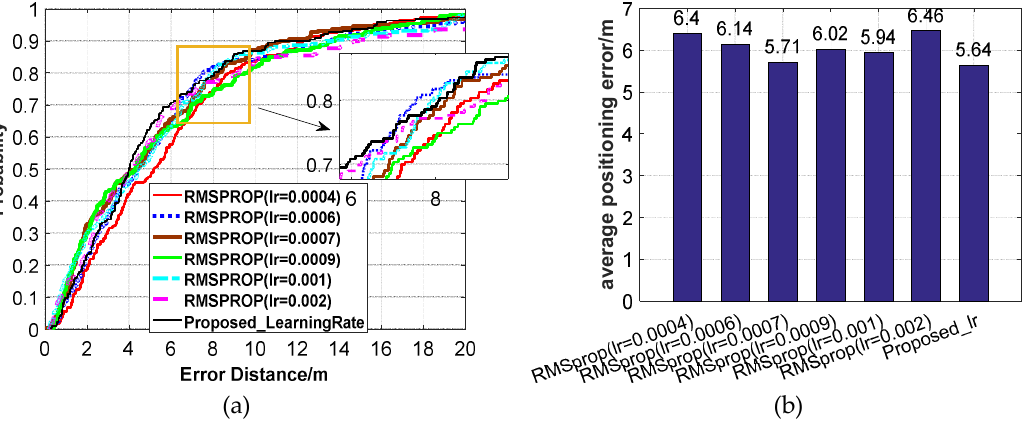
Figure 18. The positioning accuracy using different learning rates in optimizer (RMSprop). ( a ) CDF positioning errors. ( b ) Average positioning errors.